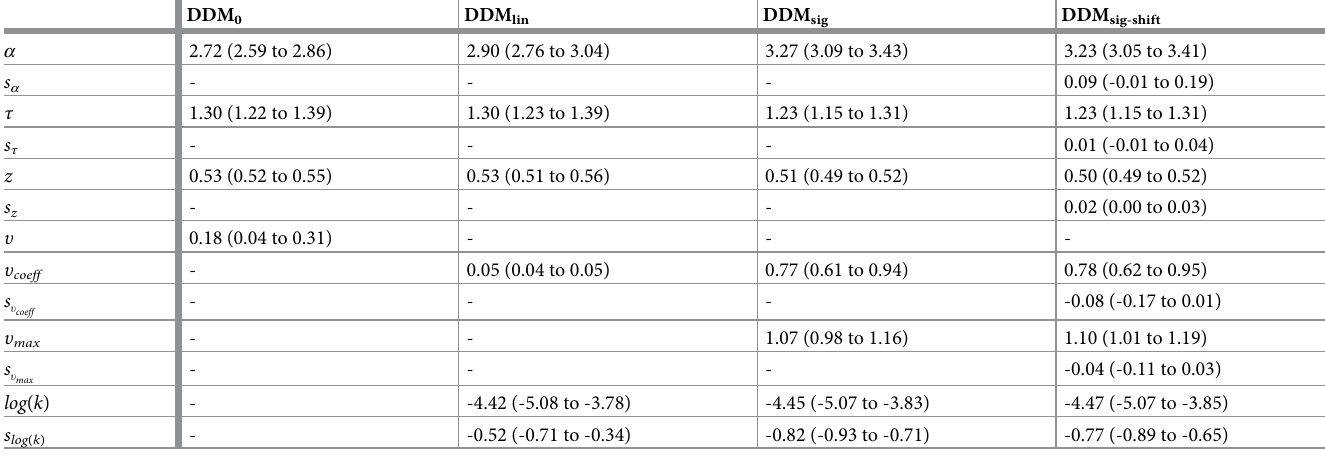
Table 4. Parameter group means and 95% HDIs of the posterior distributions of the drift diffusion models using absolute values.